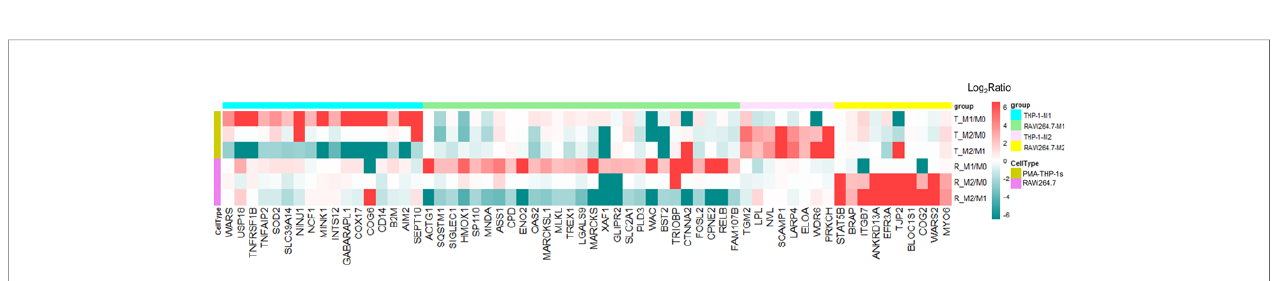
FIGURE 5 | Differentially expressed proteins between human and mouse polarized macrophage models. There were 17 and 27 proteins uniquely up-regulated in M1 subtype of human THP-1 and mouse RAW264.7 cell line, respectively. Eight and 10 proteins were uniquely up-regulated in M2 subtype of human THP-1 and mouse RAW264.7 cell models,